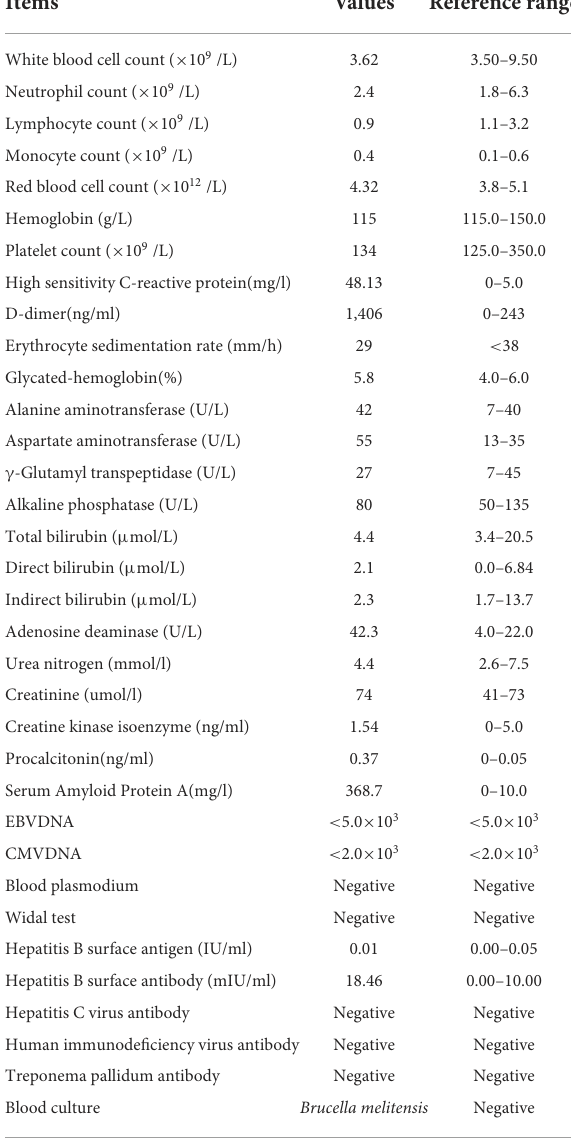
TABLE 1 Laboratory examination results of the case at